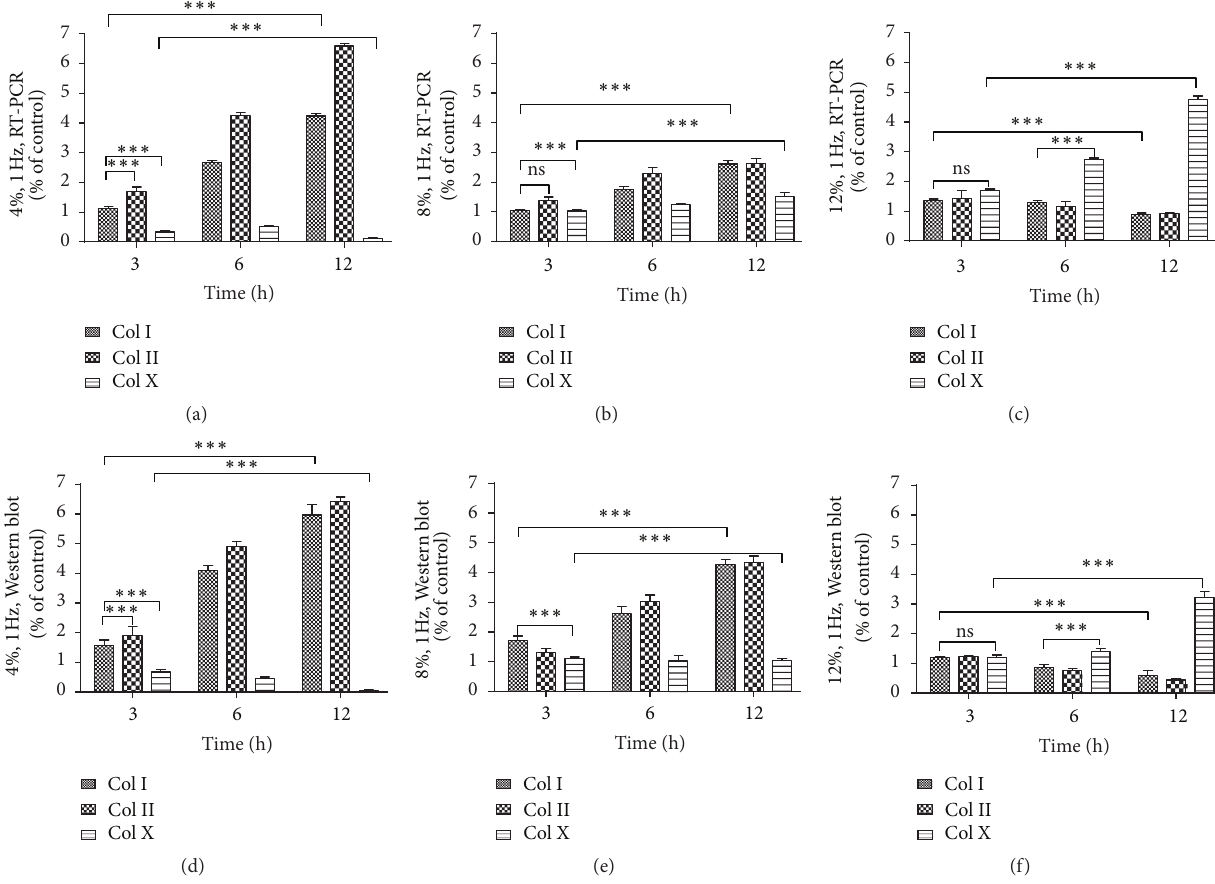
Figure 4: Types I, II, and X collagen mRNA expression under 4% (a), 8% (b), and 12% (c) CTS load for 3, 6, and 12h. Types I, II, and X collagen protein expression under 4% (d), 8% (e), and 12% (f) CTS load for 3, 6, and 12 h. Values are presented relative to the negative control group (without CTS, value of 1). All data were normalized to the control group ( 𝑛 = 3 , ∗∗∗ 𝑃 < 0.001 , ns: nonsignificant).